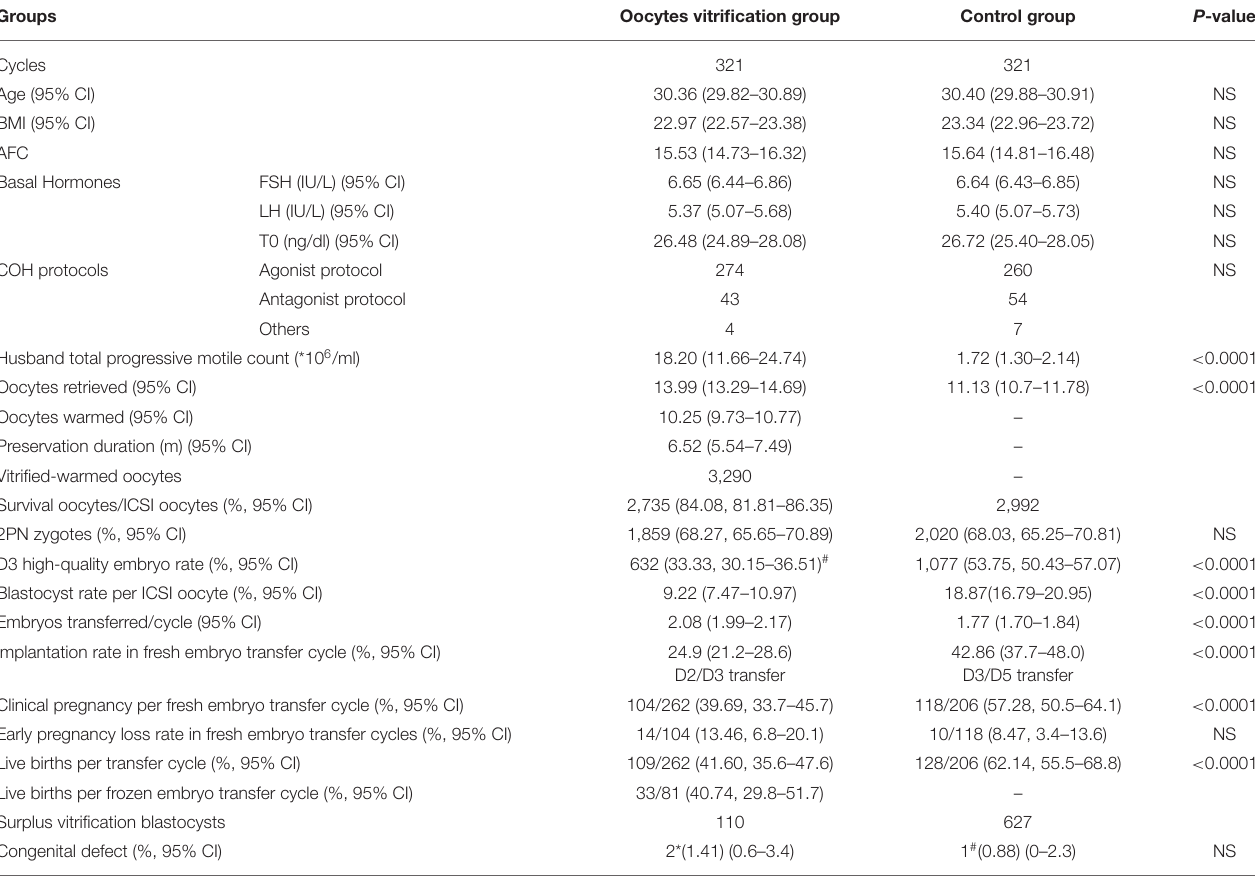
TABLE 2 | Comparison of baseline characteristics, laboratory outcome, and clinical outcome between the oocyte vitrification group and control group. Groups Oocytes vitrification